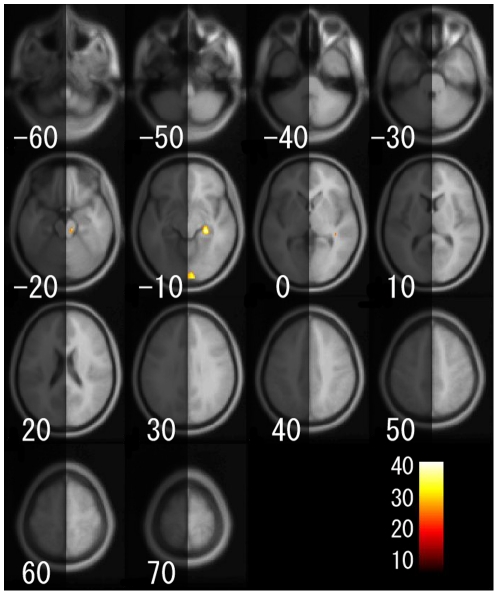
Gray matter regions that showed a significant age × gender × hemisphere interaction on regional gray matter volume.Details are the same as in Figure 4.